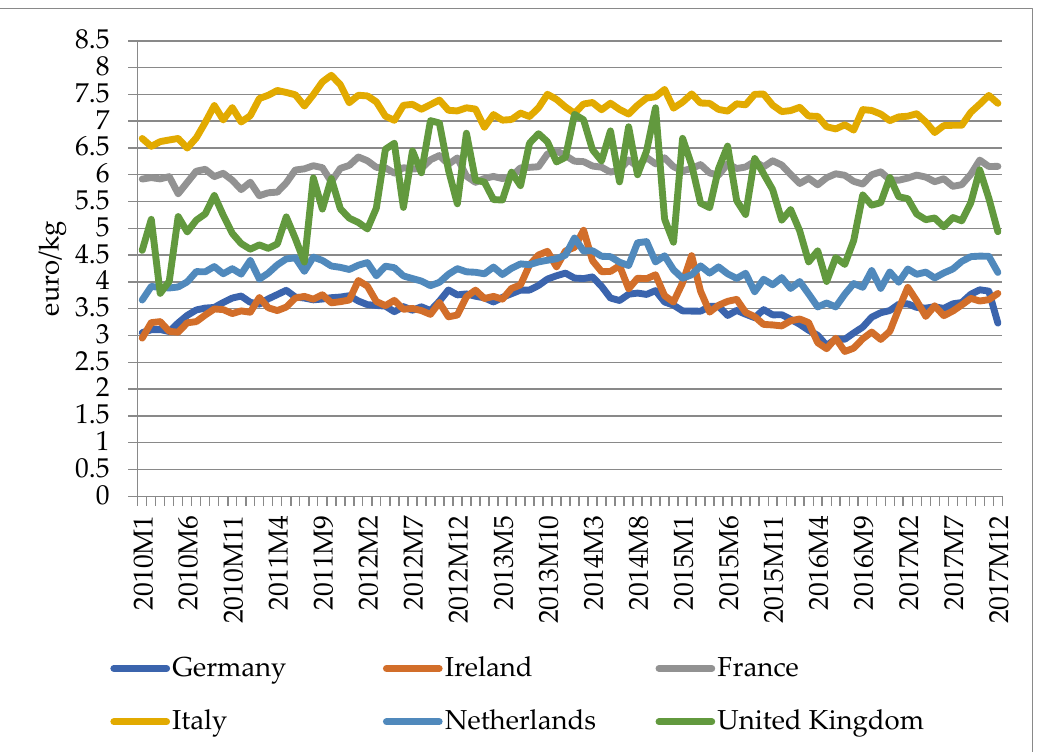
Figure 3. Intra-EU cheese export prices of major EU exporters, January 2010–December 2017. (Source: prices calculated by author using data downloaded from Eurostat Database, HS Classification EU trade since 1988 by HS2,4,6 and CN8 [DS-645593], product code: HS heading 0406–cheeses and curds, accessed in August 2019).